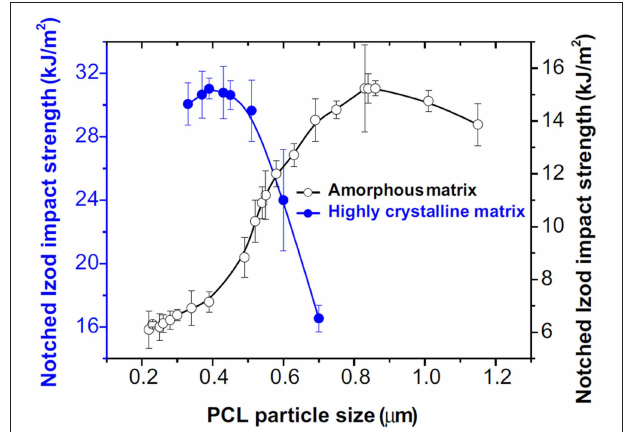
FIGURE 1 | Comparison of dependences of the impact strength on the size of PCL particles in PLA/PCL(80/20) blends with almost amorphous and with highly crystalline PLA matrices. Reprinted with permission from Bai et al. (2013). Copyright 2013, Elsevier.